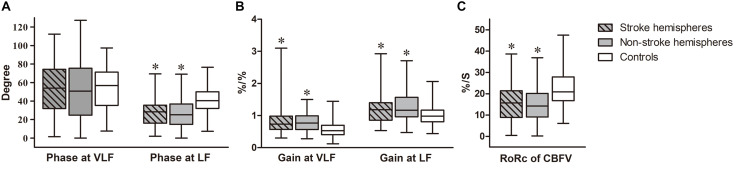
Autoregulatory parameters in ESUS patients compared to controls. Box-and-whisker plots of (A) Phase of stroke and non-stroke hemispheres in ESUS patients and controls, at very low frequency (VLF, 0.02–0.07 Hz) and low frequency (LF, 0.07–0.20 Hz) bands, respectively. (B) Gain of stroke and non-stroke hemispheres in ESUS patients and controls, at VLF and LF bands, respectively. (C) The rate of recovery of cerebral blood flow velocity (RoRc of CBFV) of stroke and non-stroke hemispheres in ESUS patients and controls. “∗” denotes P < 0.05 for comparison with controls (at corresponding frequency bands).